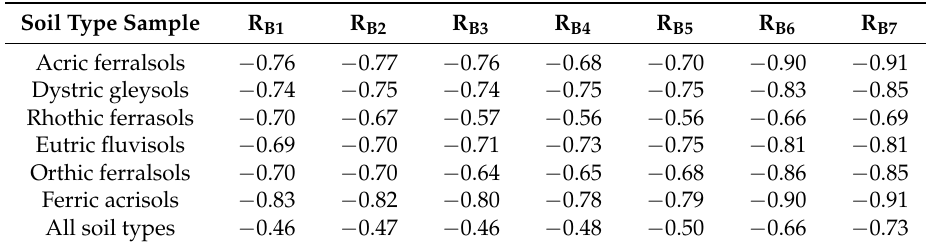
Table 3. Correlations (R, Pearson coefficient) of R rs ( λ ) corresponding to L8 band (from visible to SWIR2, B1 to B7) signals and SMC in each soil type sample, and in all cases.